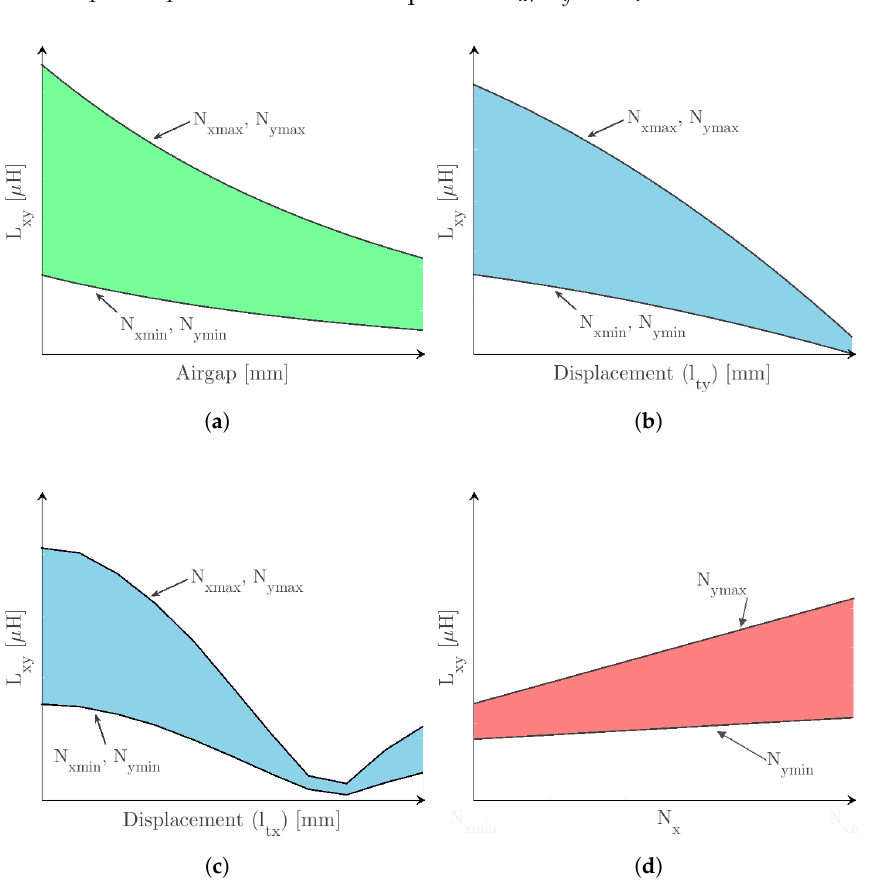
Figure 3. Profiles of L 12 and L 32 as a function of ( a ) airgap , ( b ) l tx , ( c ) l ty and ( d ) N x